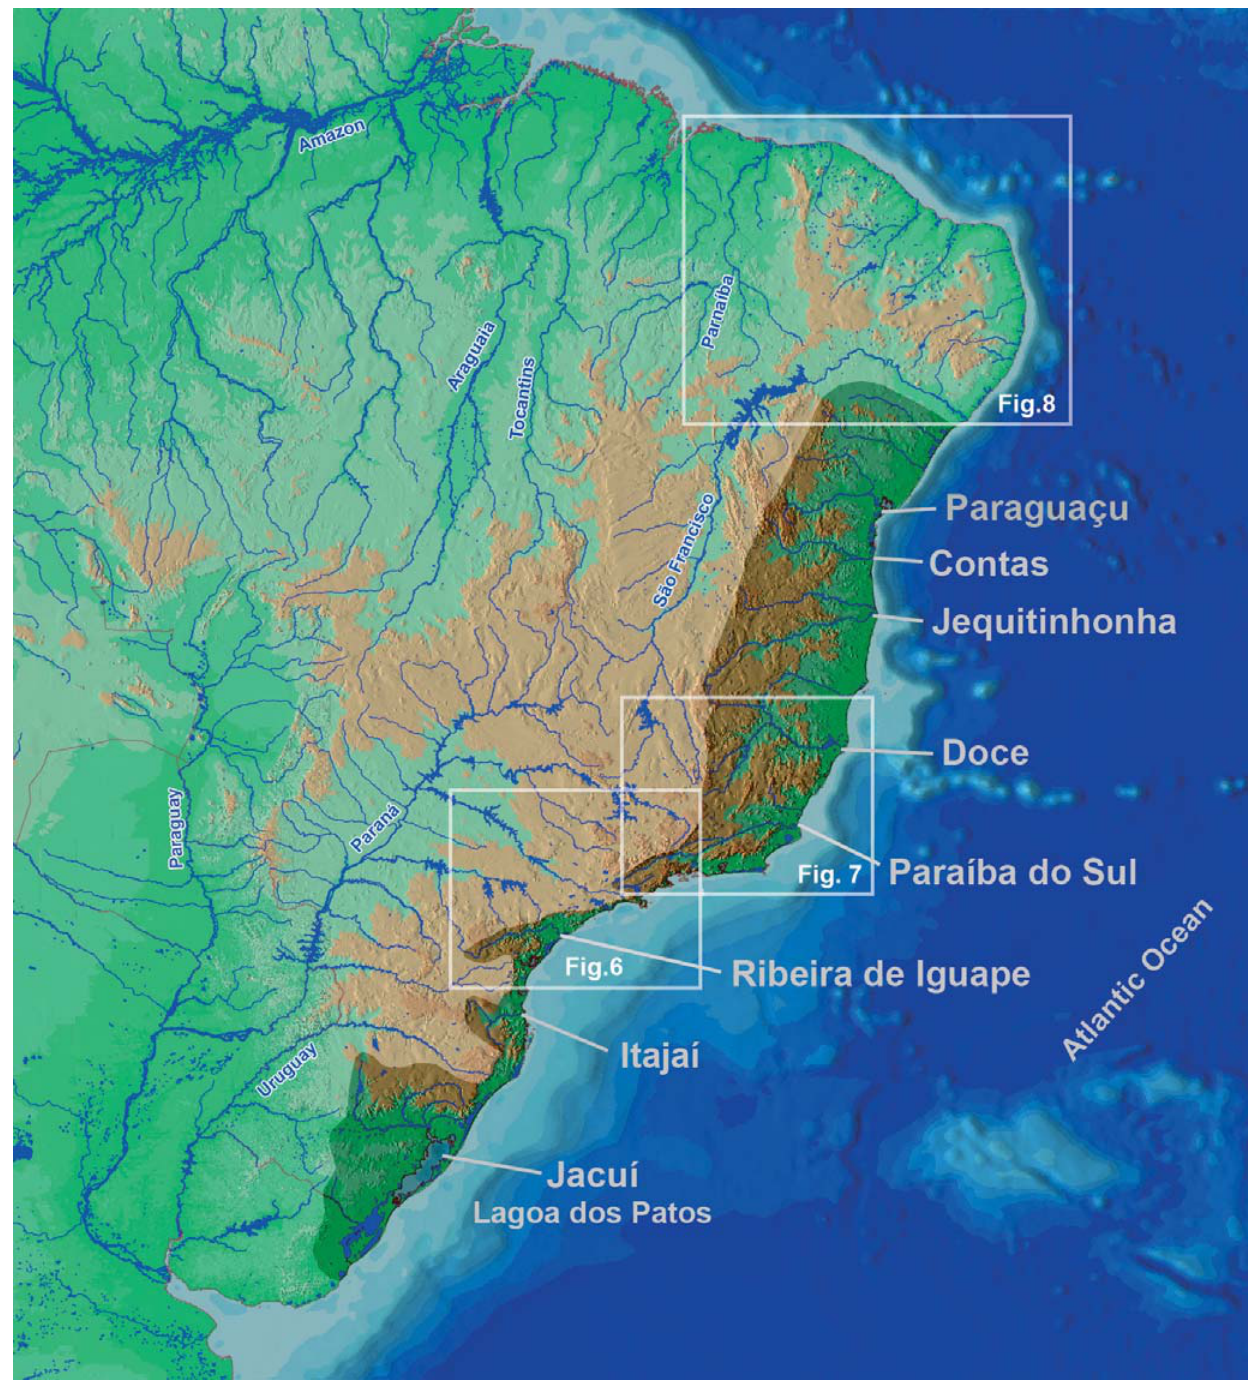
Fig. 4 . Geographic location of the Brazilian Atlantic continental margin and of the coastal drainages of eastern Brazil (shaded area) and areas showed in figures 6, 7 and 8 (modified from Hearn et al .,